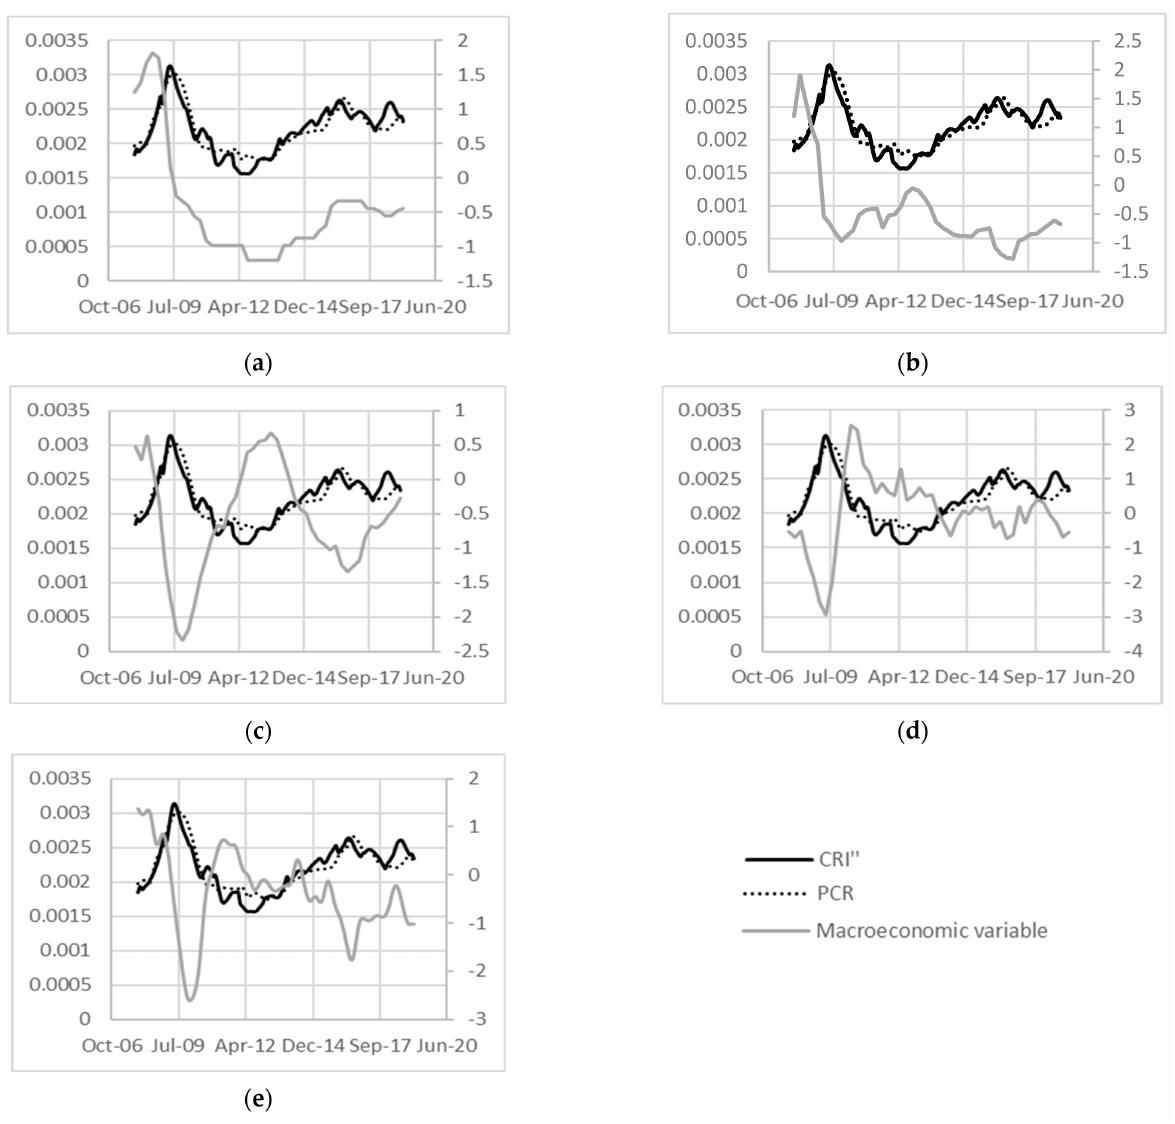
Figure 3. PCR model against macroeconomic variables and 𝐶𝑅𝐼′′ . ( a ) PR; ( b ) CEH; ( c ) ID; ( d ) NVS; ( e ) GDP_L6.